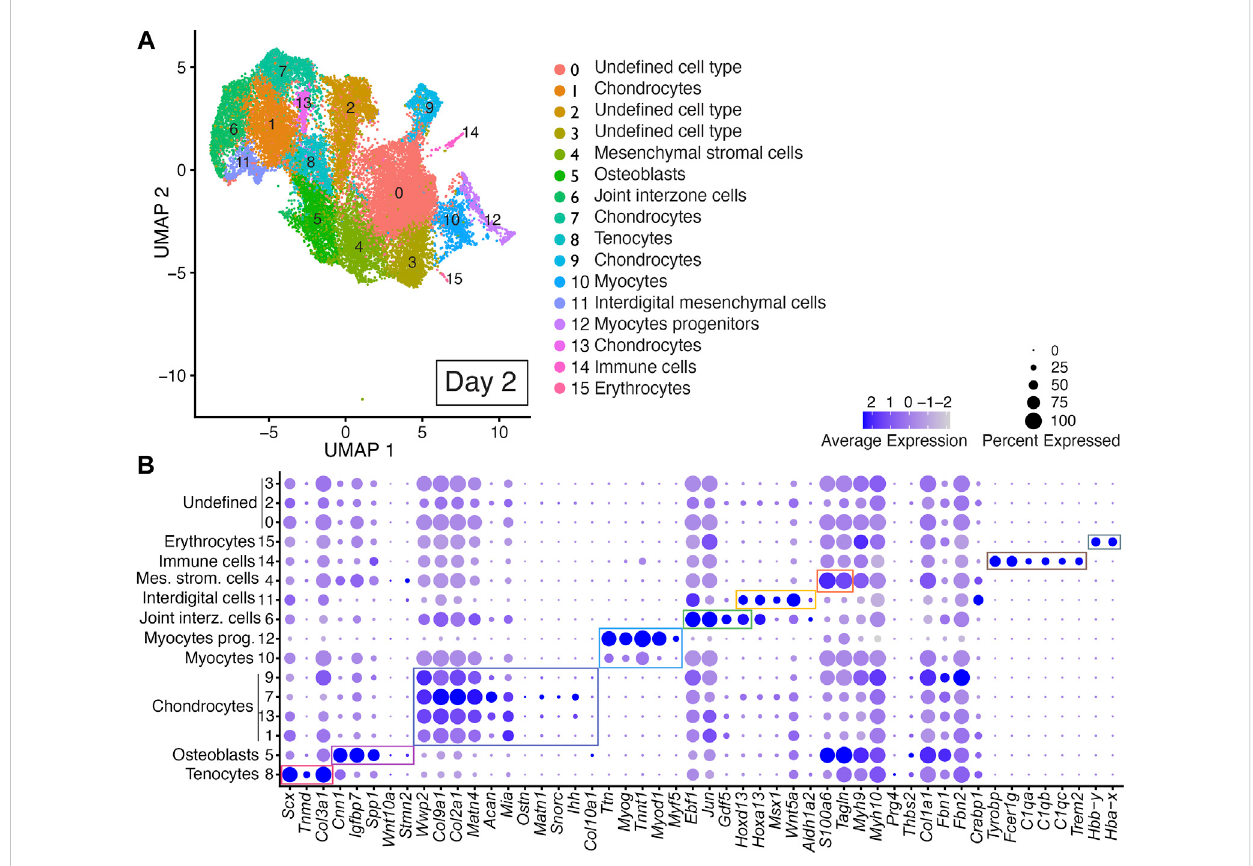
FIGURE 3 scRNAseq analysis of Day 2 in vitro cultures identi fi es multiple early autopod cell types. (A) UMAP (Uniform Manifold Approximation and Projection) plot of Day 2 culture scRNAseq results demonstrate 16 different clusters of identi fi able cell populations. Individual cells are color coded based on cluster and marker gene annotation denoting tenocytes (Clusters 8), osteoblasts (Cluster 5), chondrocytes (Clusters 1, 7, 9, and 13), myocytes (Cluster 10), myocyte progenitors (Cluster 12), joint interzone cells (Cluster 6),interdigital mesenchymal cells (Cluster 11), mesenchymal stromal cells (Cluster 4), immune cells (Cluster 14), erythrocytes (Cluster 15), and unde fi ned cell types (Clusters 0, 2, 3). (B) Dot plots highlighting expression pro fi les of selected marker genes per cell type used for cluster cell identi fi cation. Colored rectangles highlight the subset of markers used to identify tenocytes (red), osteoblasts (pink), chondrocytes (purple), myocytes/myocyte progenitors (blue), joint interzone (green), interdigital mesenchyme (orange), immune cell lineages (brown) and erythrocytes (gray). Dot diameter corresponds to thepercentage of cells expressing the gene in each cluster. High-Low expression is denoted by Purple-Gray bar,